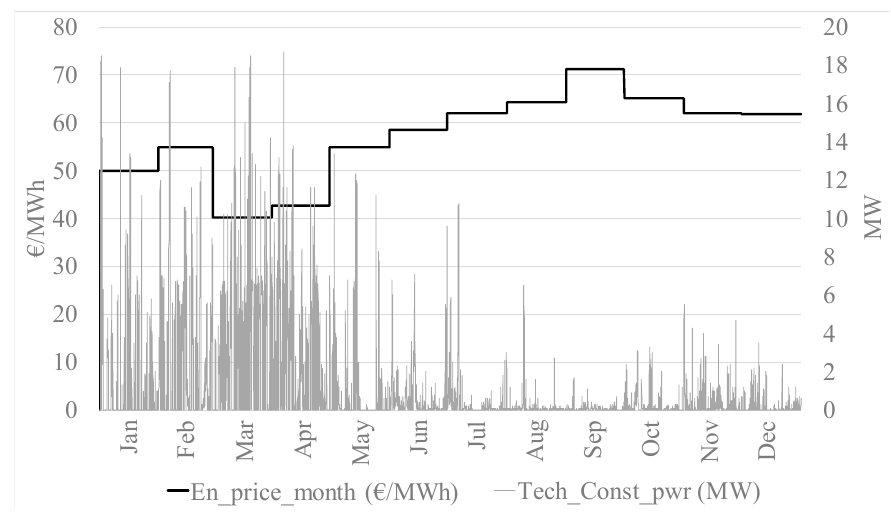
Figure 6. Power profile of technical constraints for the power plant under study for the year 2018 and average monthly energy prices.